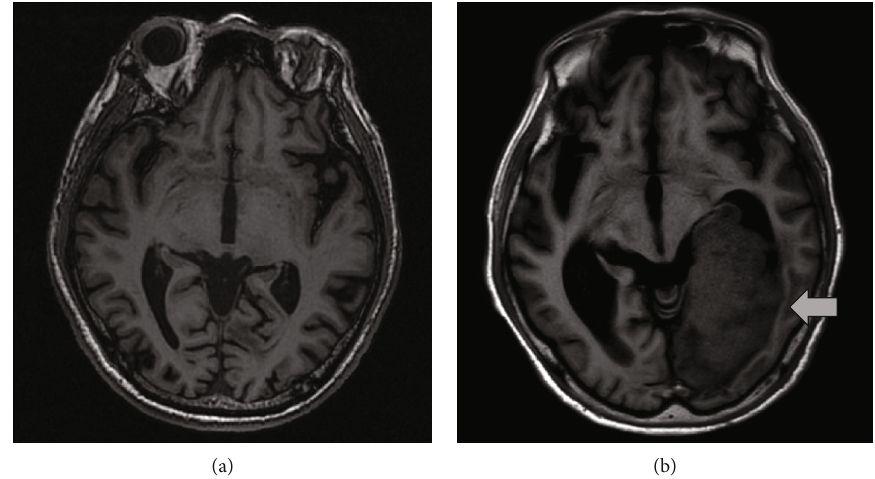
Figure 2: Brain MRI (a) 10 months after and (b) 2 years after mania onset, with a brain mass at 2 years